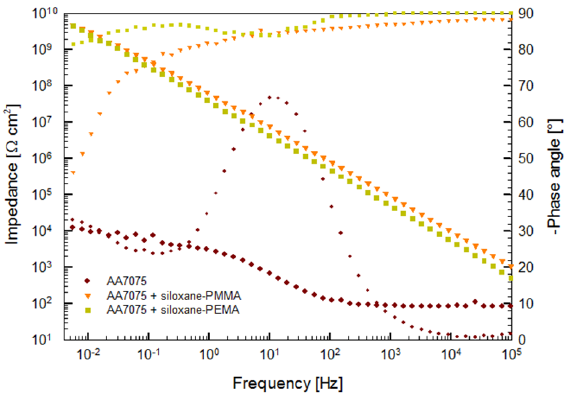
Figure 8. Bode plots of impedance magnitude and phase angle of bare AA7075-T6, and AA7075-T6 coated with siloxane-PMMA and of siloxane-PEMA coatings measured after immersion in 0.1 M NaCl for 1 day.